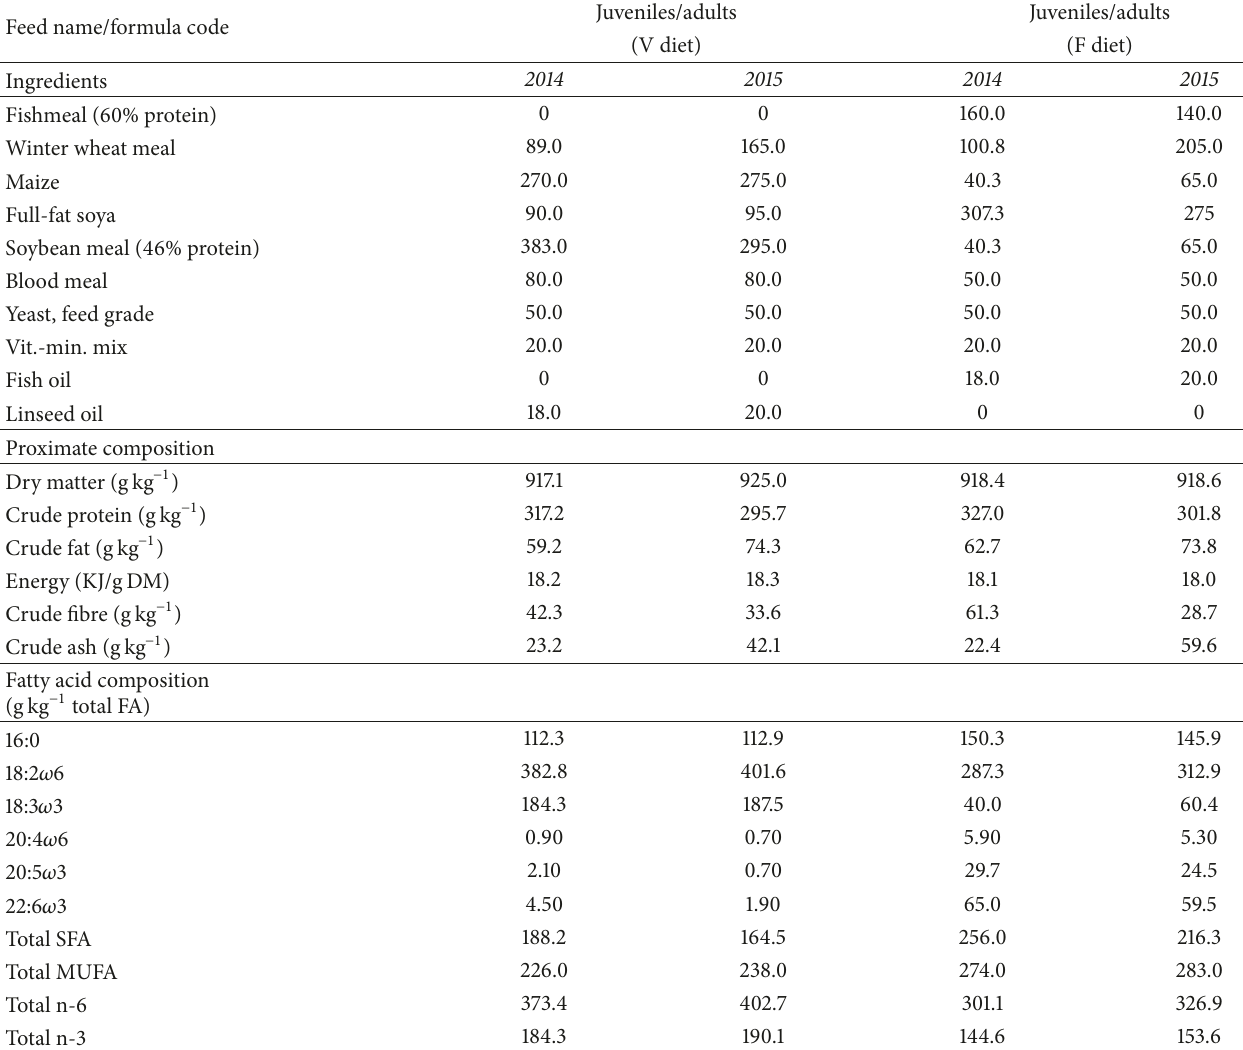
Table 3: Formulations and proximate compositions of carp feeds containing plant ingredients (P) and feeds containing low FM and FO